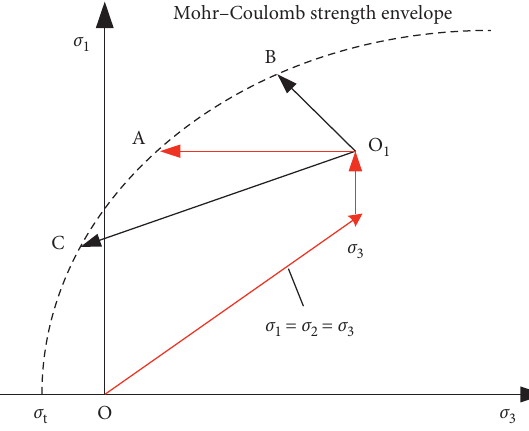
Figure 3: Schematic diagram of the stress of path in confining pressure unloading